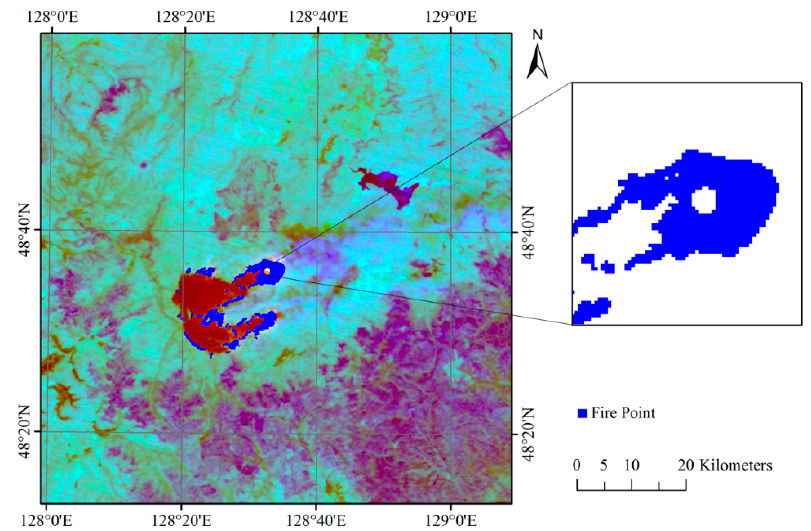
Figure 14. The fire detection results using the contextual algorithm without the absolute fire pixel judgment produced a “cavity” in the detection area. The image was acquired on 29 April. Remote Sens. 2016 , 8 , 403